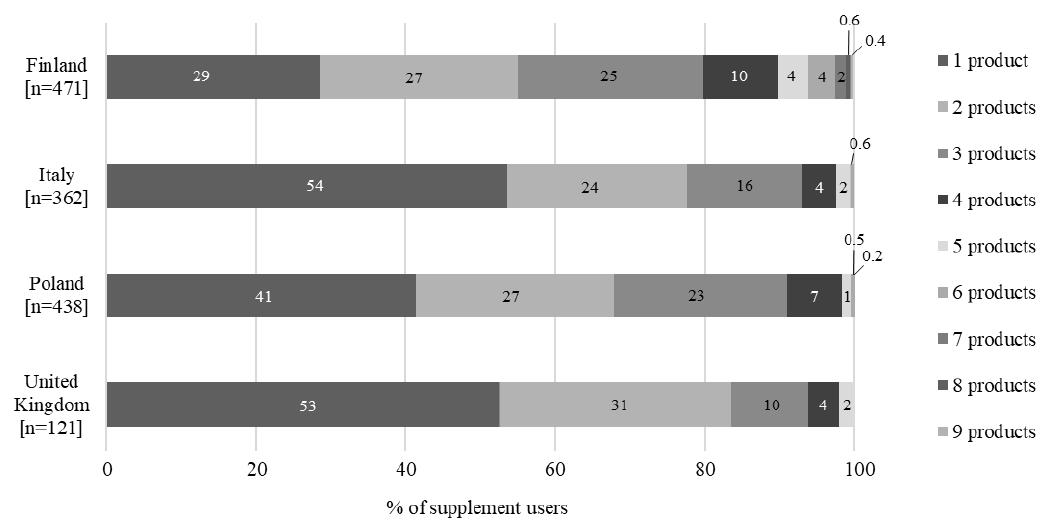
Figure 1. Proportion of supplement users using one or more food supplement products.